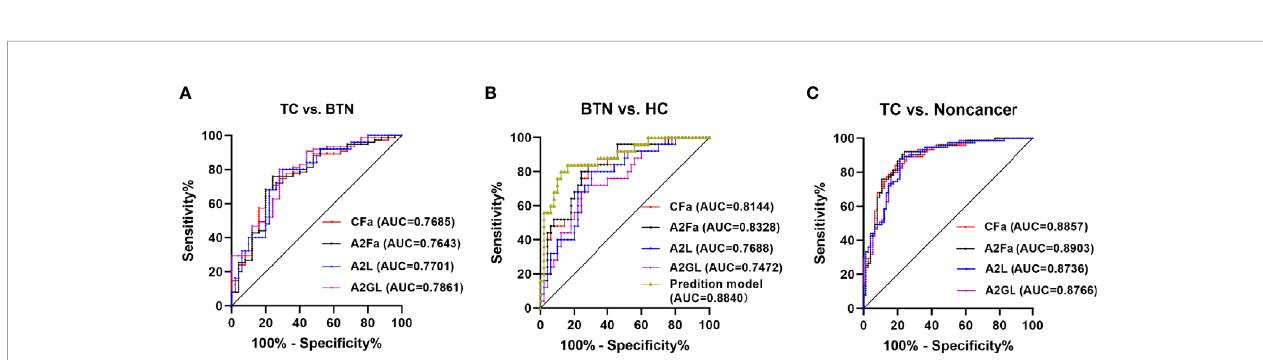
FIGURE 4 | ROC curve analysis for differential expressed derived glycan traits and prediction model based on them. (A) TC vs . BTN, (B) BTN vs . HC, (C) TC vs . Noncancer (BTN + HC). TC, thyroid cancer; BTN, benign thyroid nodules; HC, healthy